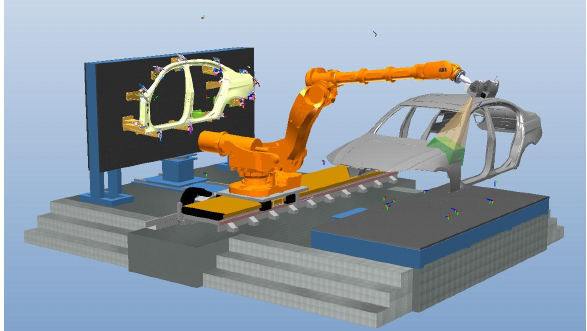
Figure 1. Industrial surface inspection cell Using virtual reality for simulation of photogrammetric tasks is the subject of a number of publications. The simulation of sensors with the description of objects, sensors and light sources is subject of Raczkowsky and Mittenbuehler (1989) or Ikeuchi and Robert (1991). Determine sensor positions by avoiding occlusion in urban scenes using VRML is described by Stamos and Allen (1998). Piatti and Lerma (2006) use a virtual simulator for photogrammetry for the determination of proper exposure stations, i.e. in urban areas with high buildings, in terms of getting maximum ground coverage with a minimum of image